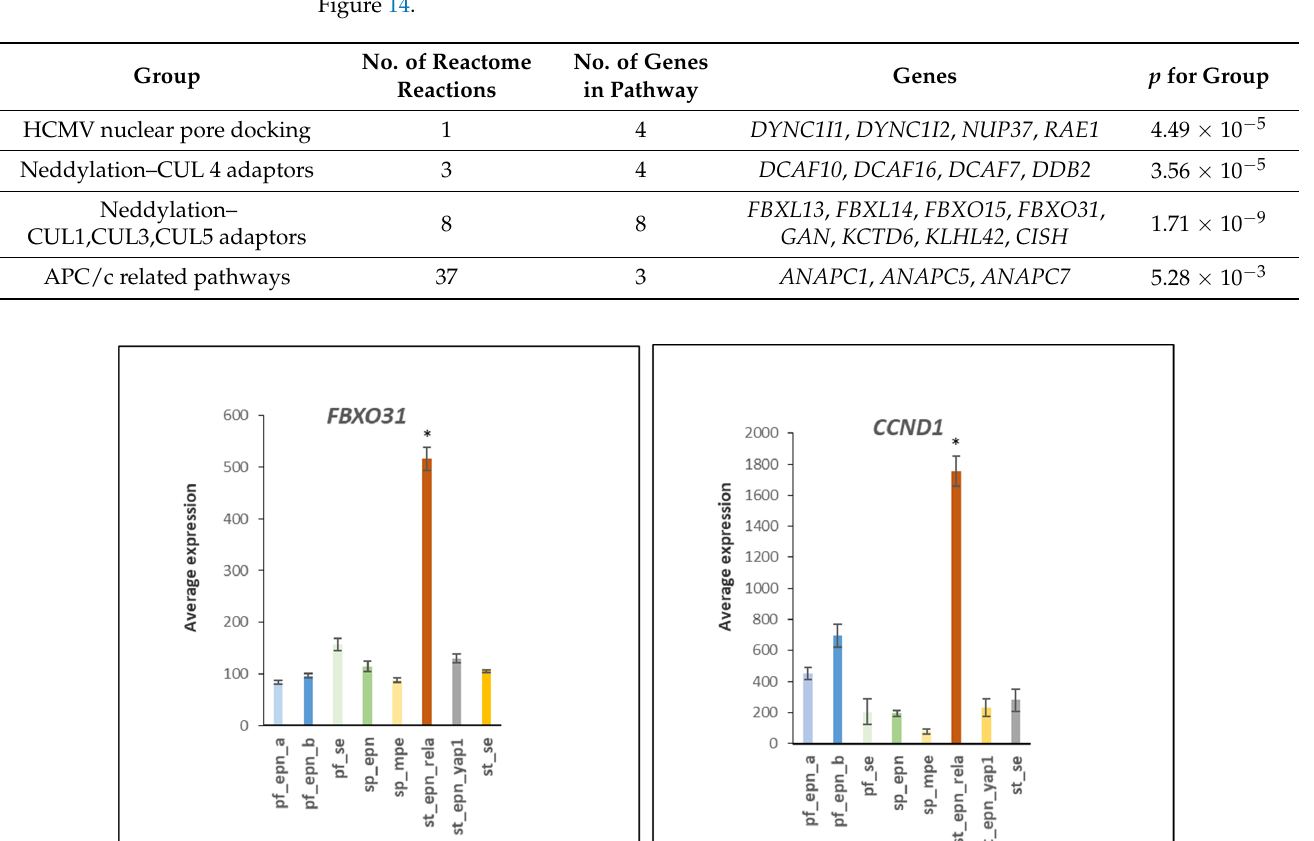
Figure 17. Elevated expression of the genes encoding ubiquitin E3 ligase adaptor FBXO31 and its substrate cyclin D1 ( CCND1 ) (by F = 153.74, p = 4.09 × 10 − 77 ; F = 51.39, p = 1.77 × 10 − 41 ) in the ST_EPN_RELA subtype. * significantly different from all other groups by t -test. Dataset GSE64415. Table 7. Main Reactome reactions over-represented by ubiquitin E3 ligase adaptor genes depicted in Figure 14.